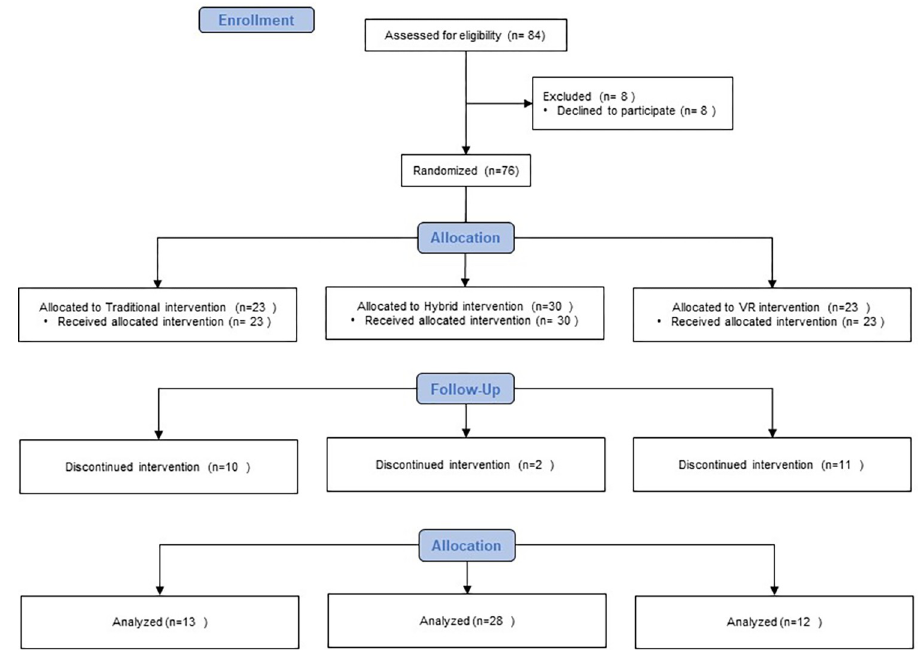
Fig 2. CONSORT diagram for recruitment.